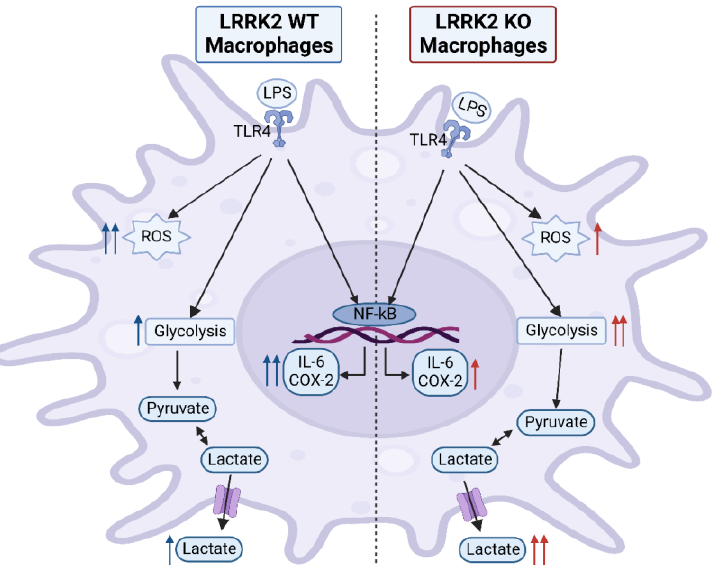
Figure 8. LPS stimulation effects in LRRK2 WT and KO RAW 264.7 cells. Stimulating RAW macrophages with LPS results in increased reactive oxygen species (ROS), inflammatory cytokine and lactate production. LRRK2 modulates these effects. Compared to KO cells, LRRK2 showed an increase in ROS production and IL-6 and COX-2 levels, while glycolysis was reduced, indicated by a lowered lactate level. This figure was created with BioRender.com.